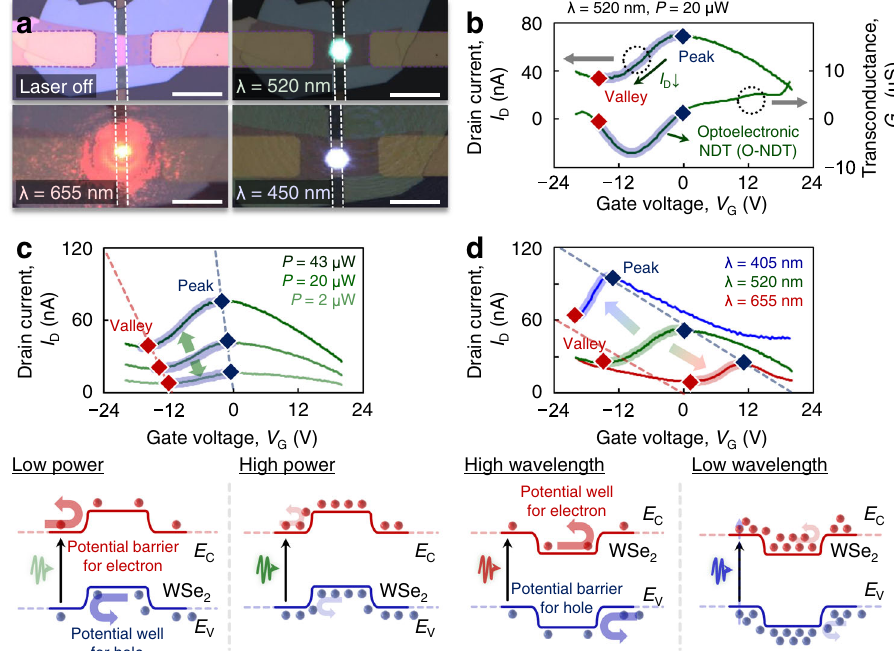
Fig. 3 Controllability for the NDT phenomenon. a OM images of the PG-NDT device under laser-off and laser-on conditions. b I D − V G and G m − V G characteristic curves showing the optoelectronic NDT (O-NDT) phenomenon. c I D − V G characteristic curves showing the O-NDT phenomenon under different laser power conditions (top) and energy band diagrams at negative V G under different laser power conditions (bottom). d I D − V G characteristic curves showing the O-NDT phenomenon under different laser wavelength conditions (top) and Energy band diagrams for negative V G under different laser wavelength conditions